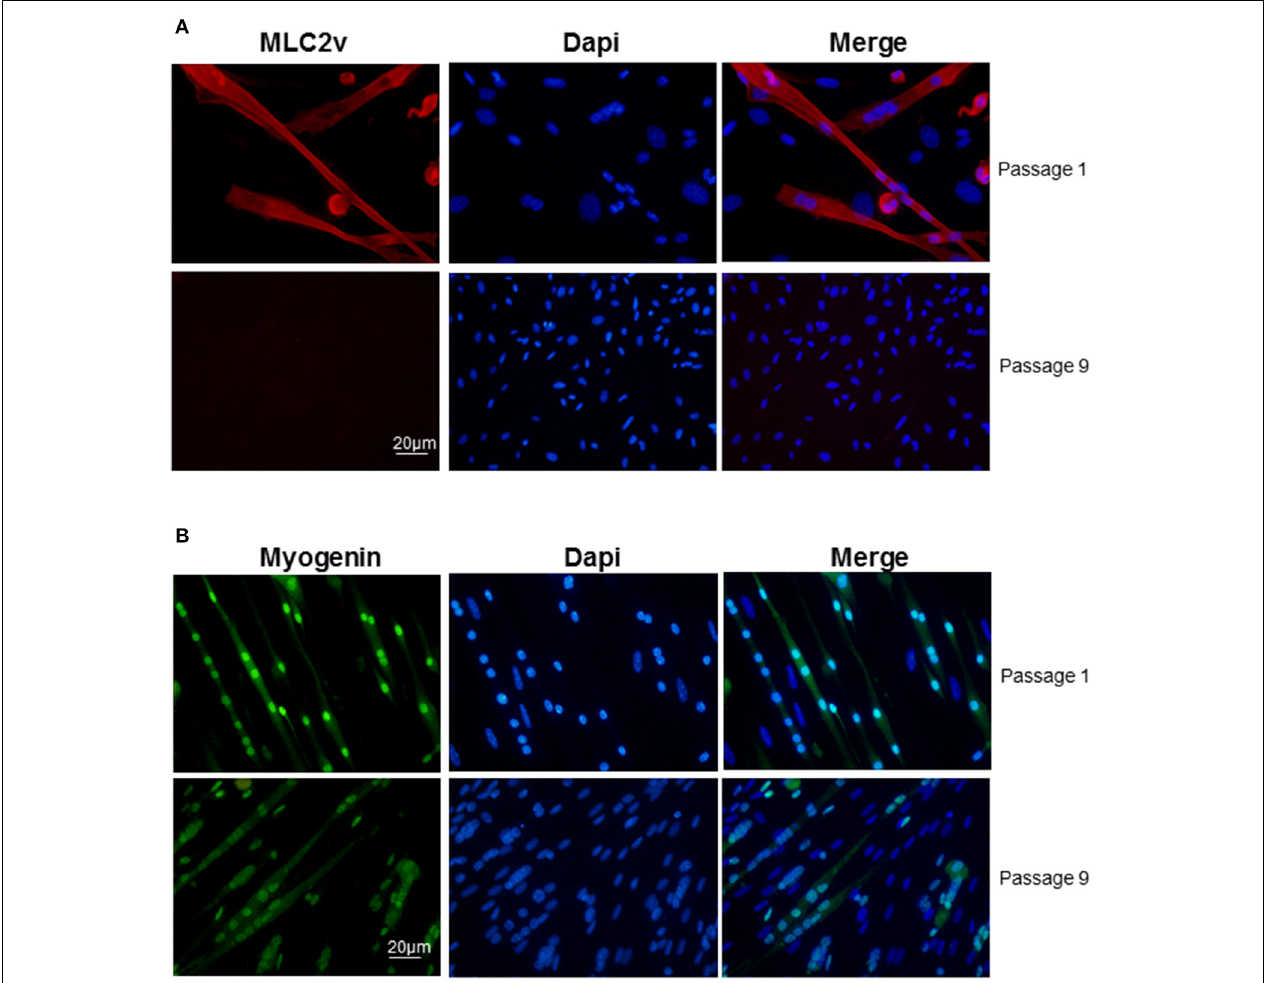
FIGURE 3 | Decline of cardiac/skeletal myogenic phenotype in liquid culture conditions. Immunolabeling of (A) myogenin (green) and (B) MLC2v (red) in myogenic clusters at passages 1 and 9 in liquid medium. Nuclei were stained with Dapi